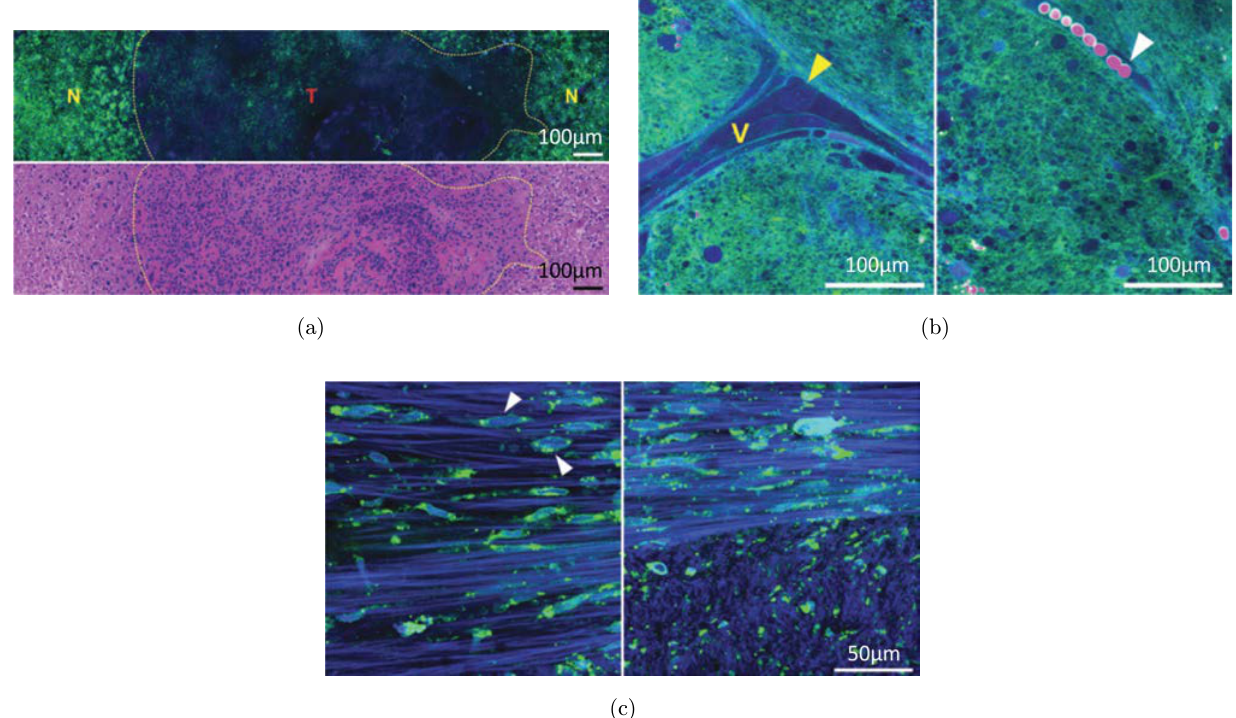
Fig. 6. Additional diagnostic feature of SRS images of human brain tissues: (a) Necrosis ð N Þ surrounding viable tumors ð T Þ , (b) blood vessels ð v Þ and red blood cells, and (c) massive collagen deposition in a recurrent GBM case